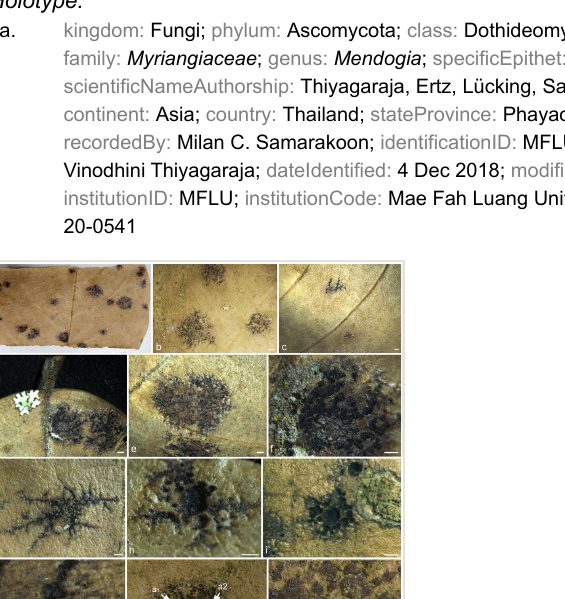
Figure 1. Mendogia diffusa (MFLU 20-0541) a, b, d–l. Ascomata on upper leaf surface; c. Ascomata on lower leaf surface; arrows point the algae. Scale bars: b = 1000 μ m, g–j = 500 μ